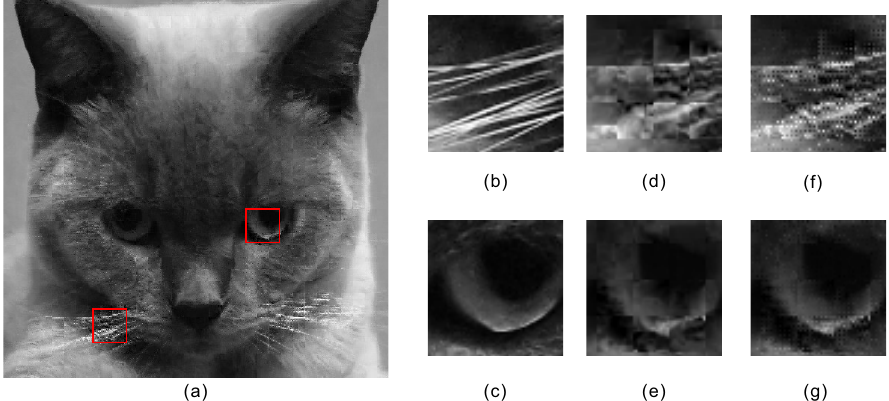
Figure 8. Fractal interpolated Cat image by a factor of 2 to 512 × 512 at the 15th iteration with range block size of 8 × 8 interleaved with low-resolution Cat image pixel layer (PSNR = 26.41 dB, SSIM = 0.8542): ( a ) the full interpolated image; zoom-in portion of the whiskers of ( b ) the original Cat image, ( d ) the interpolated image by fractal decoding with κ = 16 × 16, and ( f ) the interpolated image by fractal interpolation with interleaving; zoom-in portion of the eye of ( c ) the original Cat image, ( e ) the interpolated image by fractal decoding with κ = 16 × 16, and ( g ) the interpolated image by fractal interpolation with